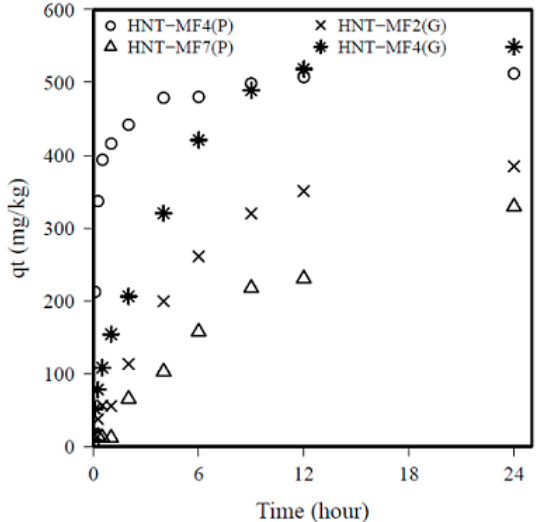
Figure 2. Kinetic experiments for the adsorption of phosphate onto halloysite nanotubes (HNT) material in powder and granular form.